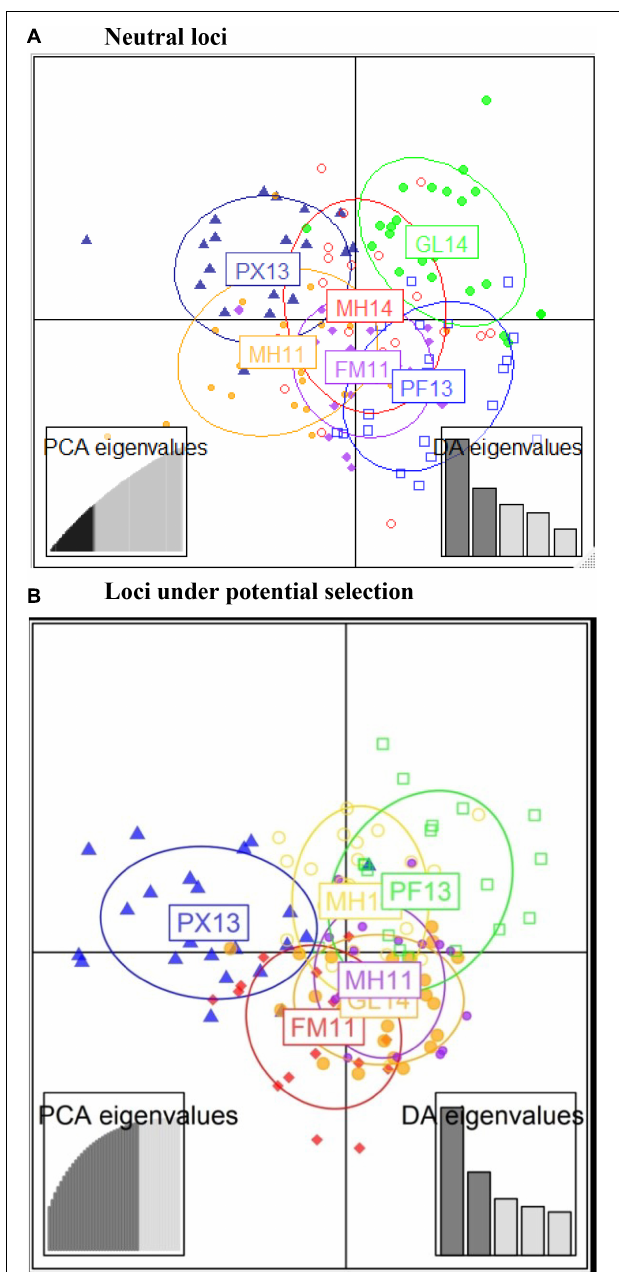
FIGURE 2 | Discriminant analysis of principal components (DAPC) depicts the extent to which bigeye tuna individuals overlap between population clusters using (A) neutral and (B) outlier SNP